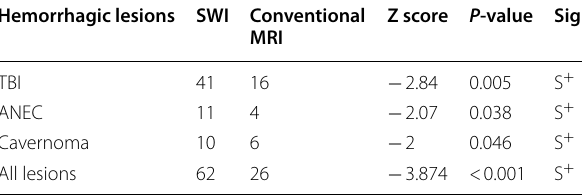
Table 2 Number of hemorrhagic brain lesions in the SWI and conventional